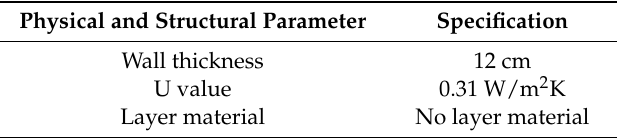
Table 2. Detail physical and structural parameter of miniature house.